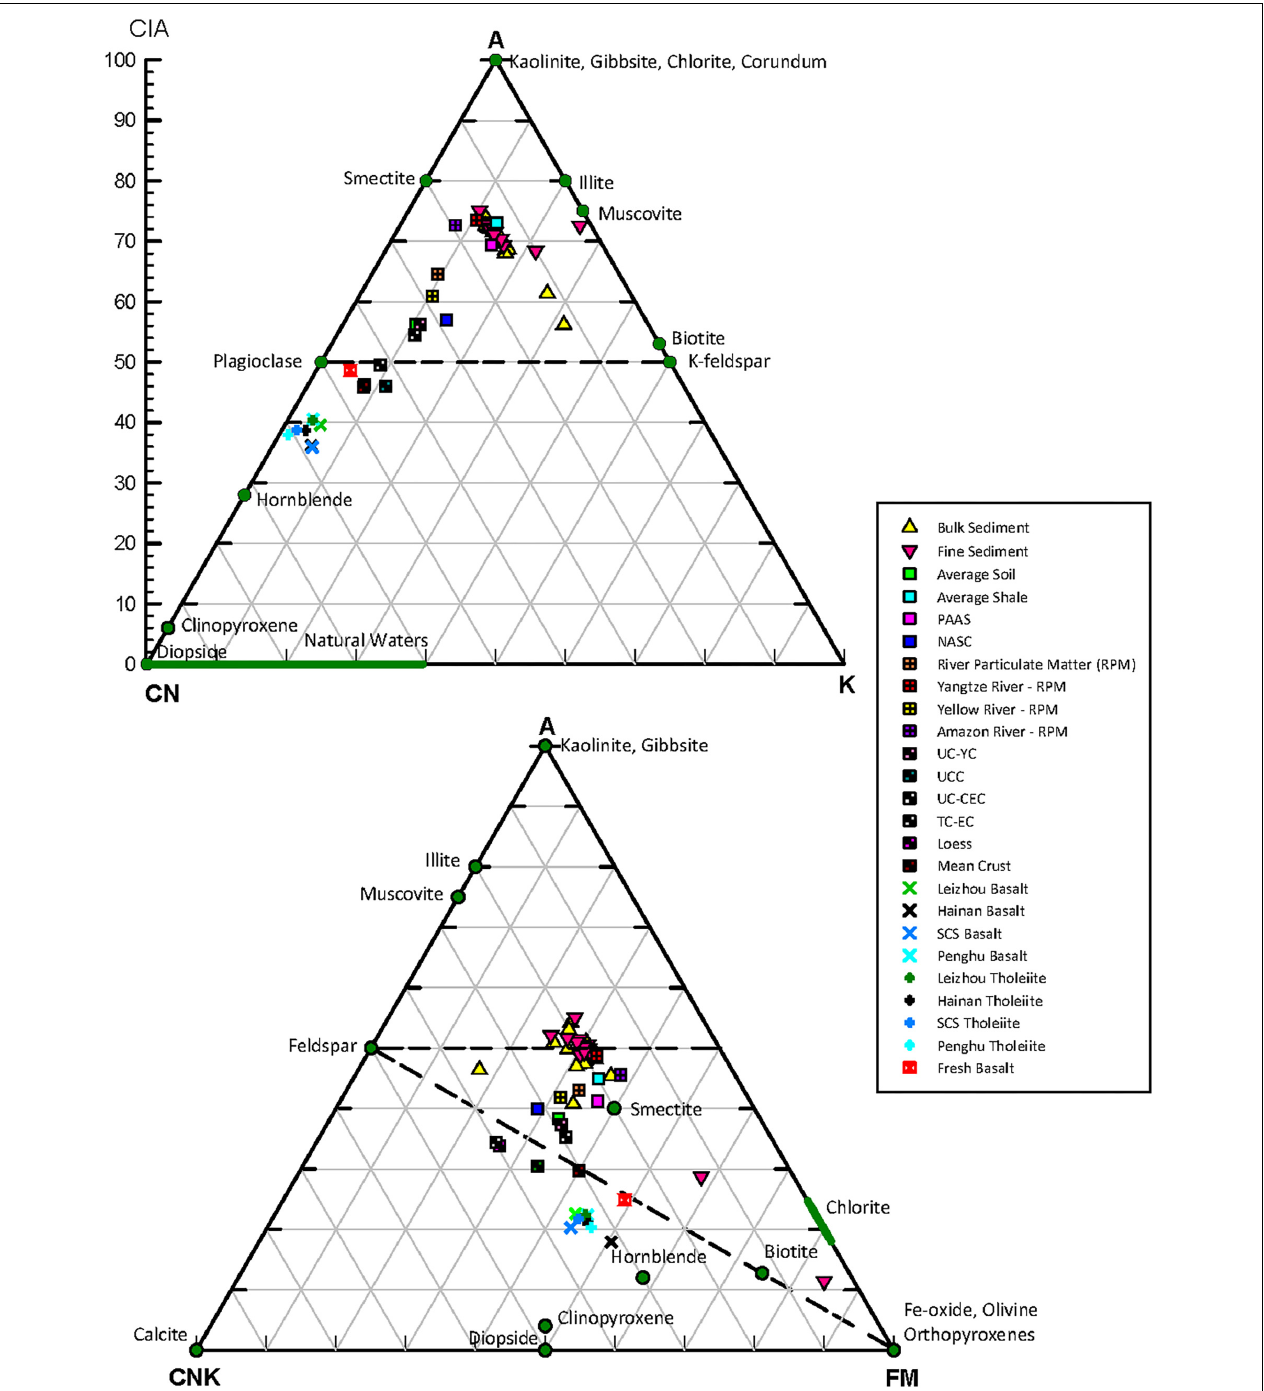
FIGURE 5 | Triangular silicate weathering diagrams (A-CN-K and A-CNK-FM) showing surface sediments from the Gulf of Tonkin. Also shown are reference compositions, upper continental crust (UCC; Taylor and McLennan, 1985), upper crust of Yangtze Craton (UC-YC; Gao et al., 1998), average shale and other river